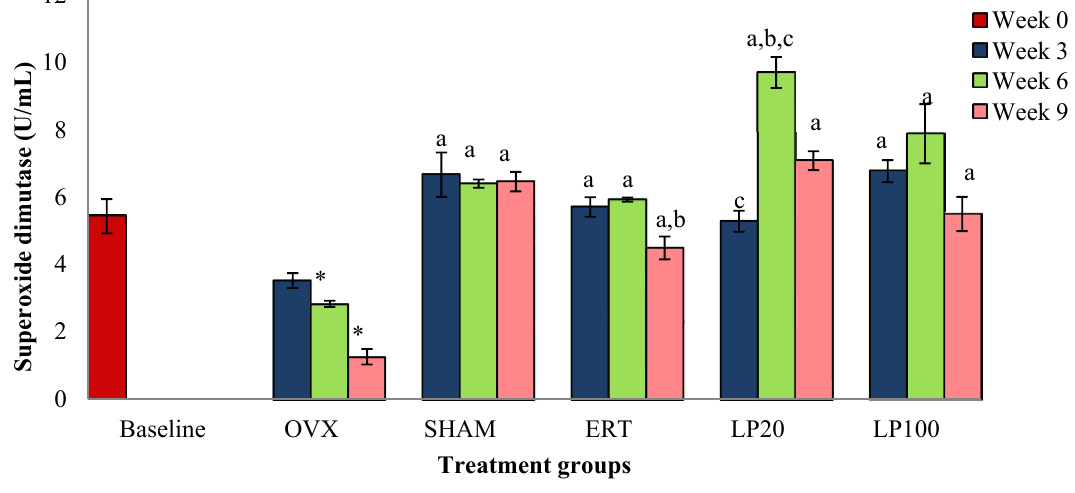
Figure 1. Mean superoxide dismutase concentration for all the groups after 3, 6 and 9 weeks of treatment. Data presented mean ± SEM ( p < 0.05). SHAM: sham-operated, OVX: ovariectomized control, ERT: ovariectomized and estrogen supplementation, LP20: ovariectomized and supplemented with LP at the dose of 20mg/kg, LP100: ovariectomized and supplemented with LP at the dose of 100 mg/kg. * p < 0.05 versus Baseline; a p < 0.05 versus OVX at the corresponding weeks; b p < 0.05 versus SHAM at the corresponding weeks, c p < 0.05 versus ERT at week 6.